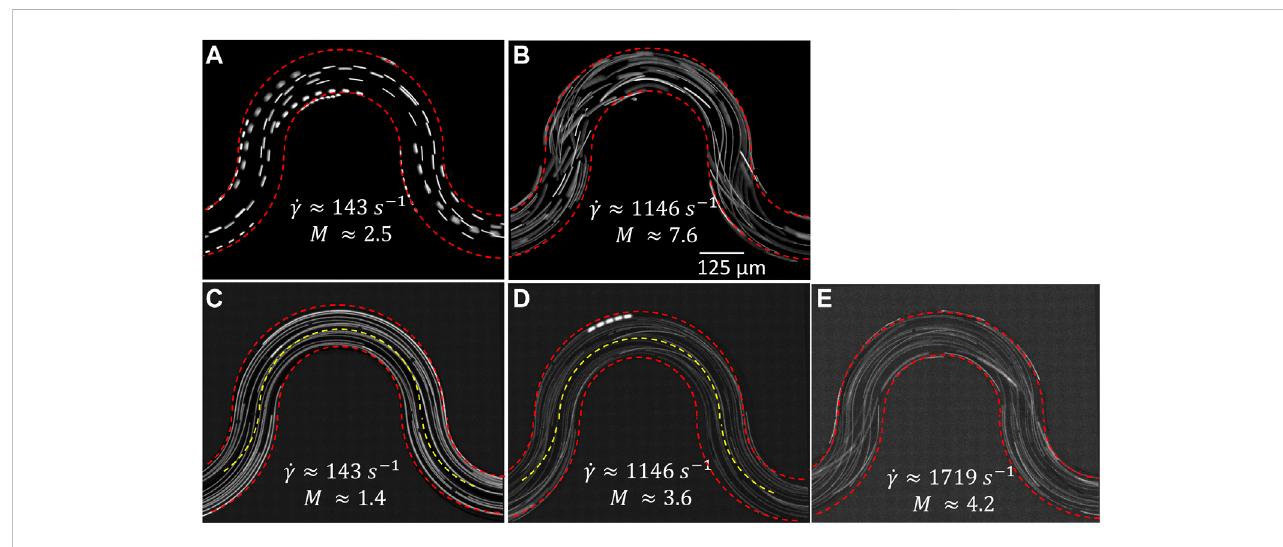
FIGURE 10 Path lines obtained by fl uorescence microscopy for 0.10 w% Flopaam 3630 at (A) _ γ ≈ 143s − 1 and (B) _ γ ≈ 1146 s − 1 , and 0.25 w% Flopaam 3330 at (C) _ γ ≈ 143s − 1 , (D) _ γ ≈ 1146s − 1 and (E) _ γ ≈ 1719s − 1 . The red dashed lines indicate the boundary of the serpentine channels. The yellow dashed lines in (C) and (D) indicate the center line of the channel as a guide to the eye rates to highlight the evolution from laminar to turbulent fl ow.